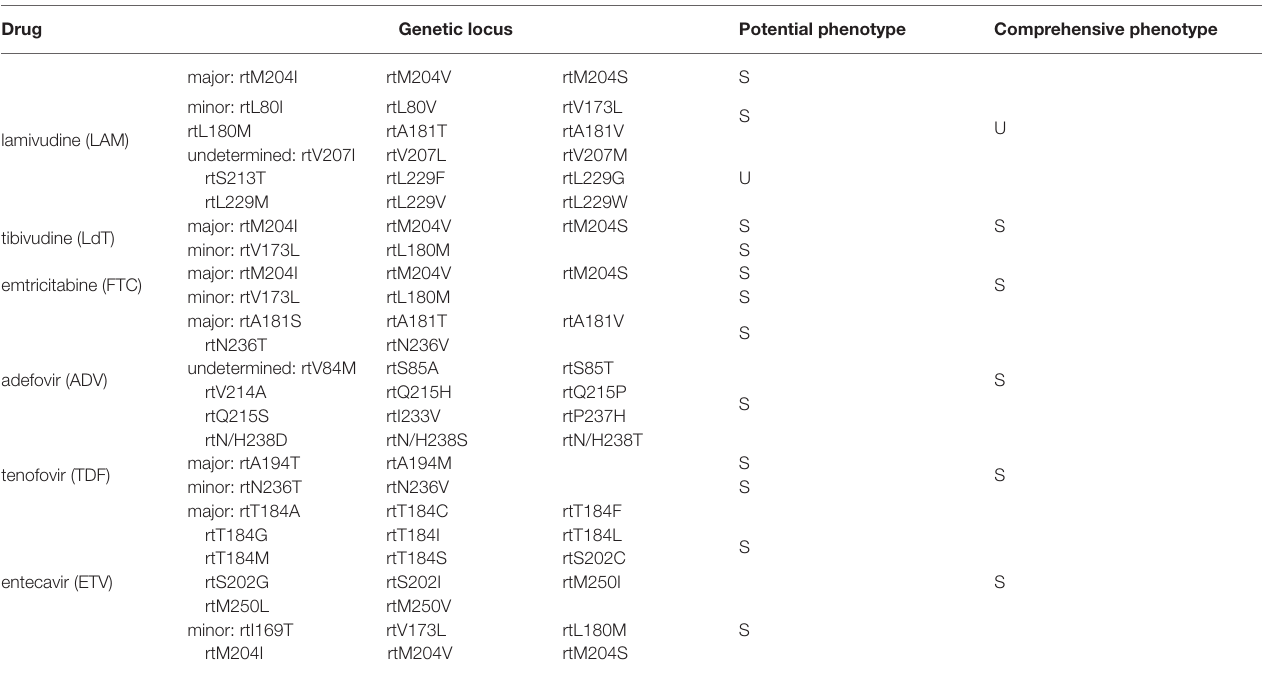
TABLE 2 | The results of drug resistance gene examination of hepatitis B virus (HBV; July